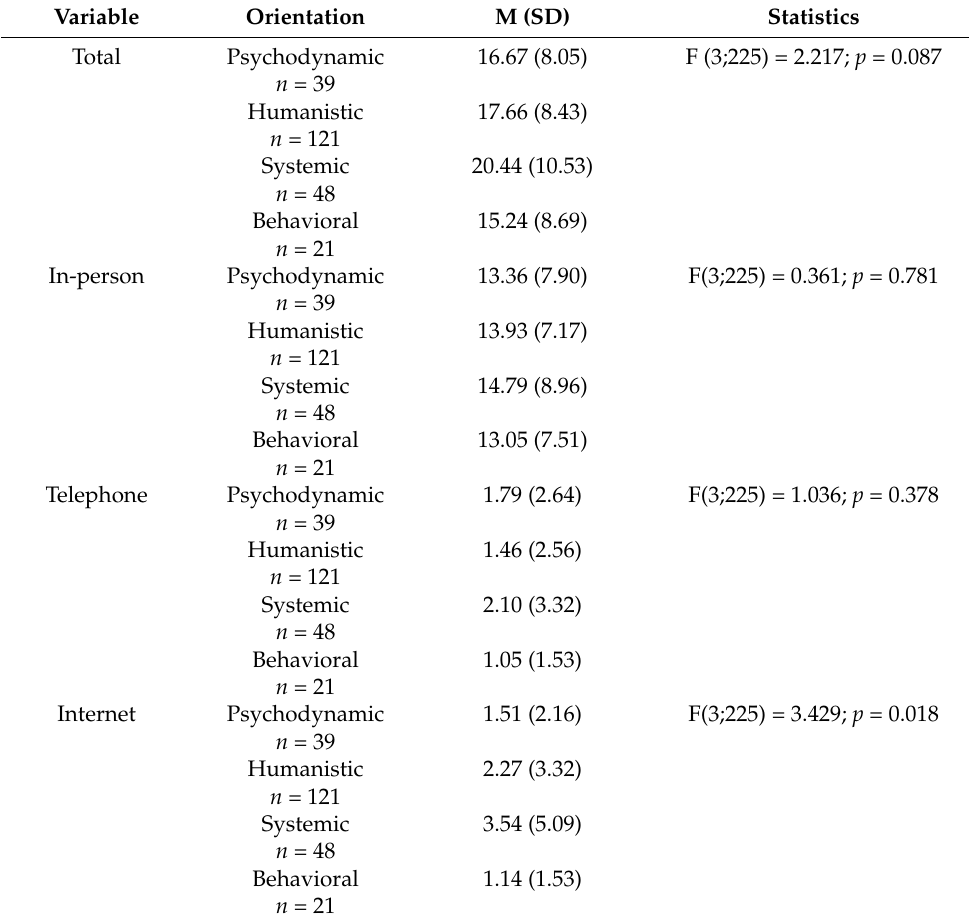
Table 3. Numbers of patients treated during the COVID-19 lockdown per treatment format and